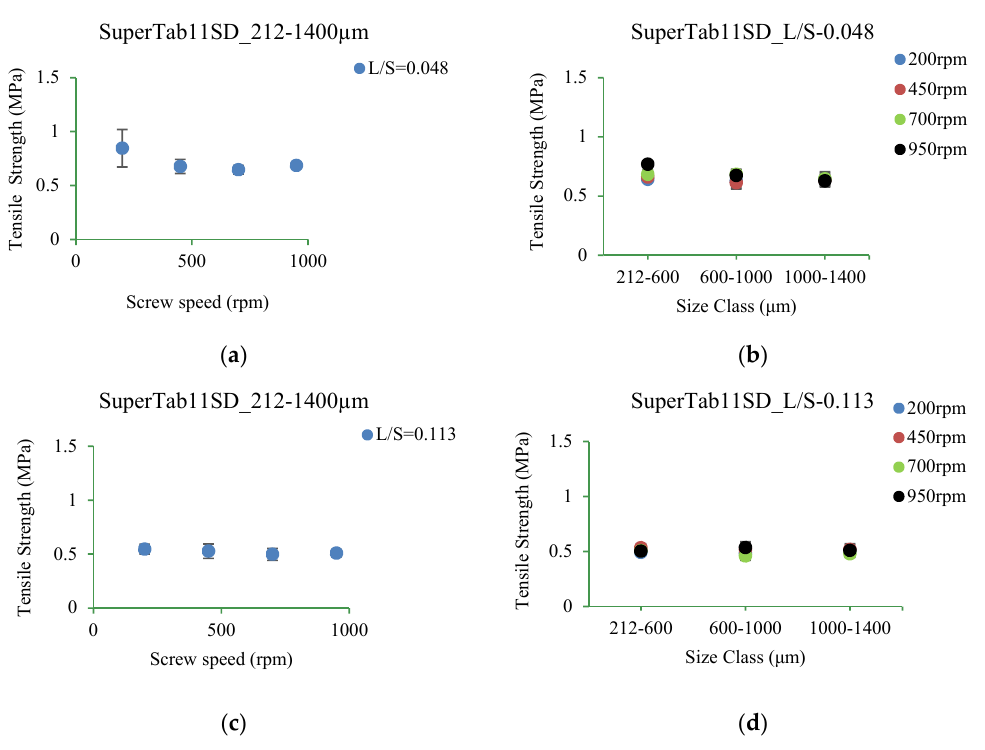
Figure 15. Tensile strength of tablet of granules at different size classes of Pharmatose 200M. ( a ) 212–